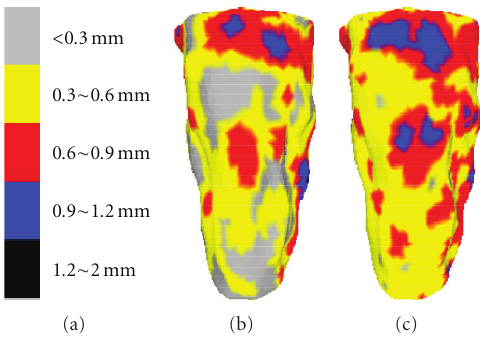
Figure 23: Representation error in in vivo experiment: (a) color- coded scales, (b) example representation error in testing set, (c) 90% representation error of testing set.